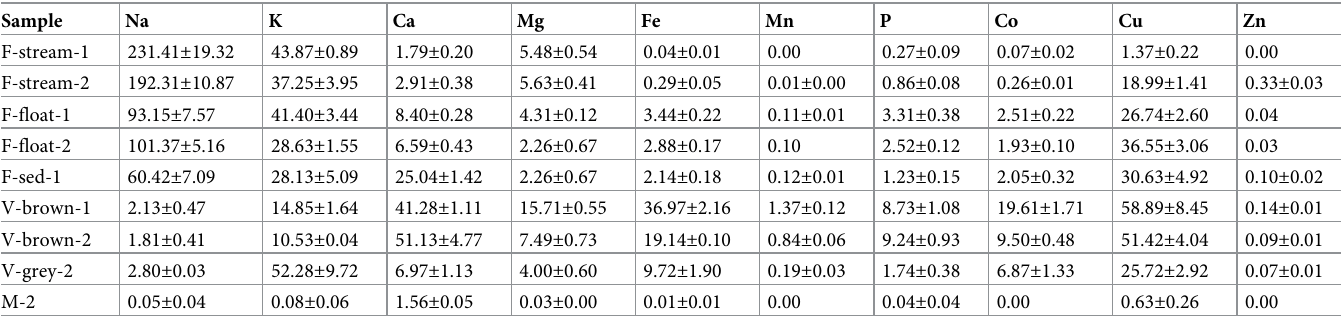
Table 3. Chemical elements in the biodeposits from Fetida Cave a .